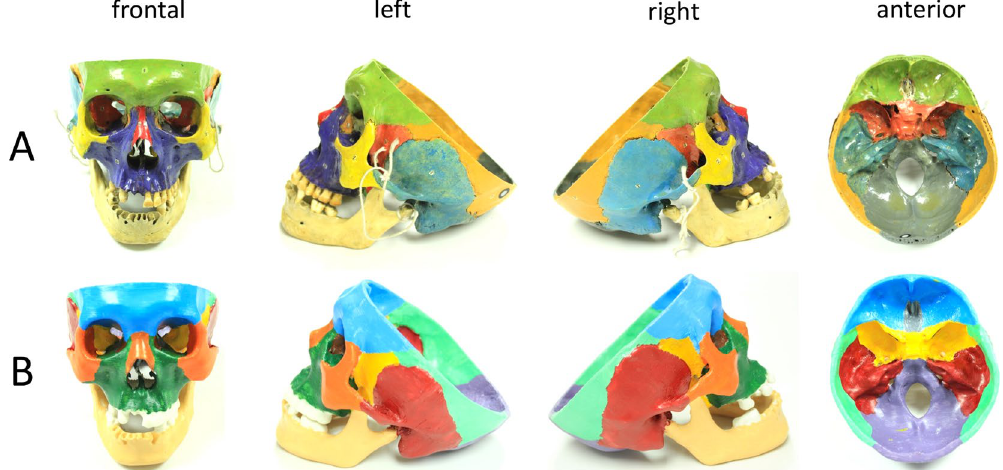
Figure 1. Photos of cadaveric skull and 3D-printed skull. ( A ) Cadaveric skull is showed in frontal, left, right and anterior views, respectively. Another four cadaveric skulls along with this one are used as teaching material for group 1. ( B ) 3D-printed skull is showed in frontal, left, right and anterior views, respectively. Five same 3D-printed skulls are used as teaching material for group